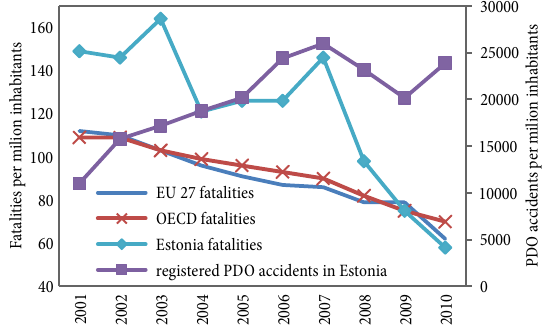
Fig. 1. Road fatalities per million inhabitants in EU, OECD Member States and Estonia compared with registered Property Damage Only (PDO) accidents (Motor Third